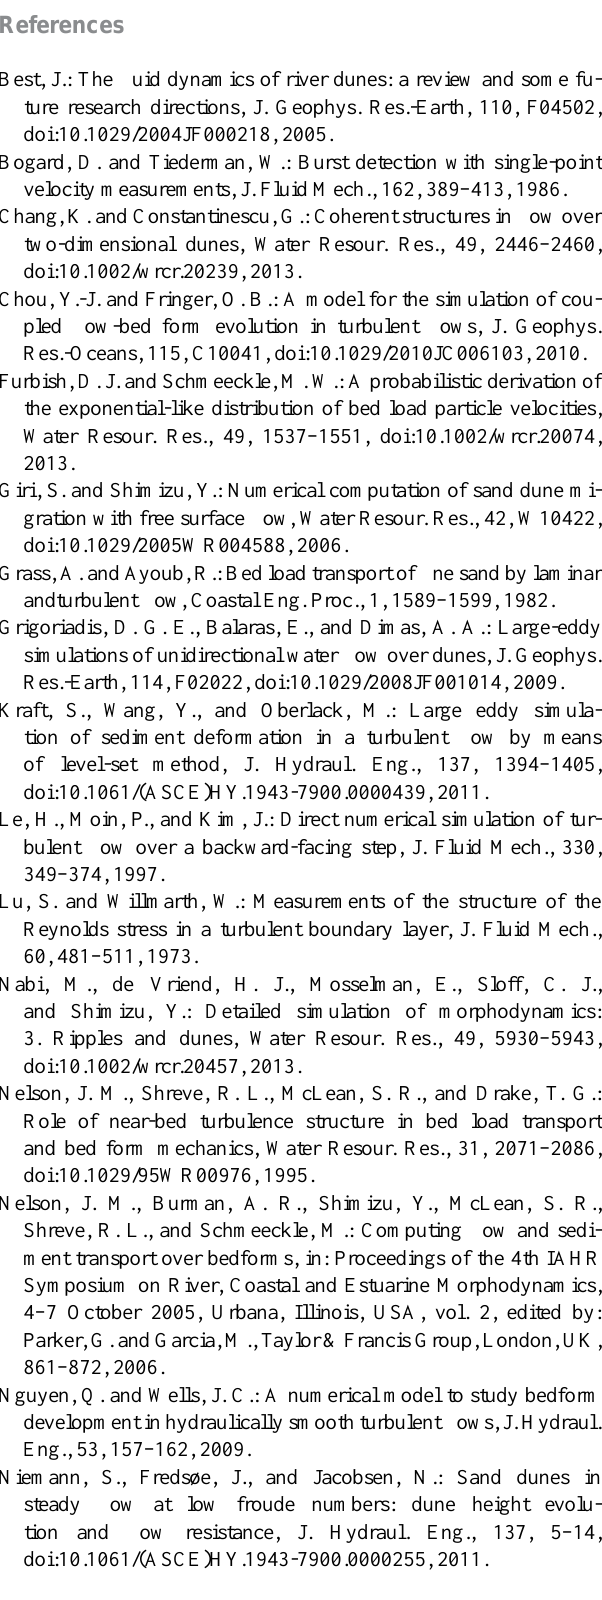
Figs. 1 and 5 at x/h step ≈ 17. When a broad sweep